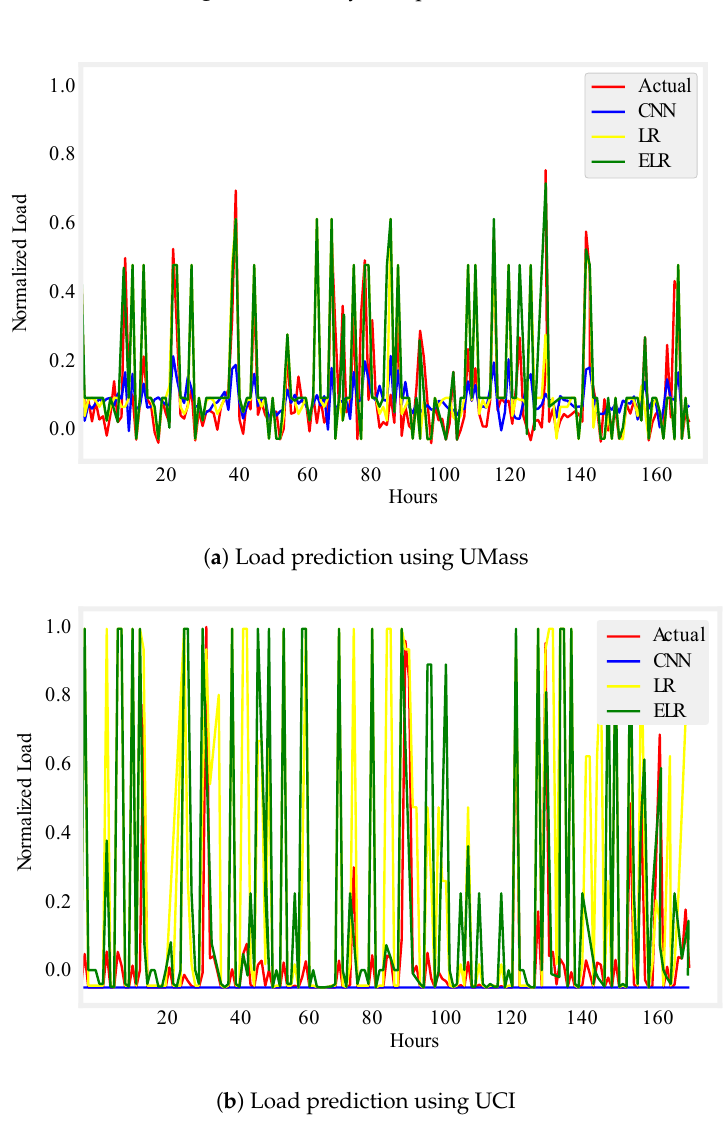
Figure 5. One day load prediction.